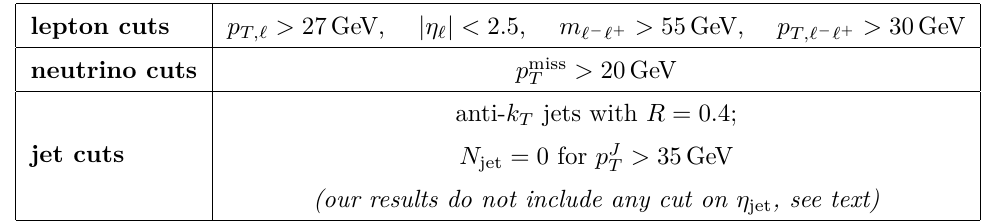
Table 1 . Fiducial cuts corresponding to the 13 TeV ATLAS analysis [75]. See text for details. evaluate the EW coupling α =